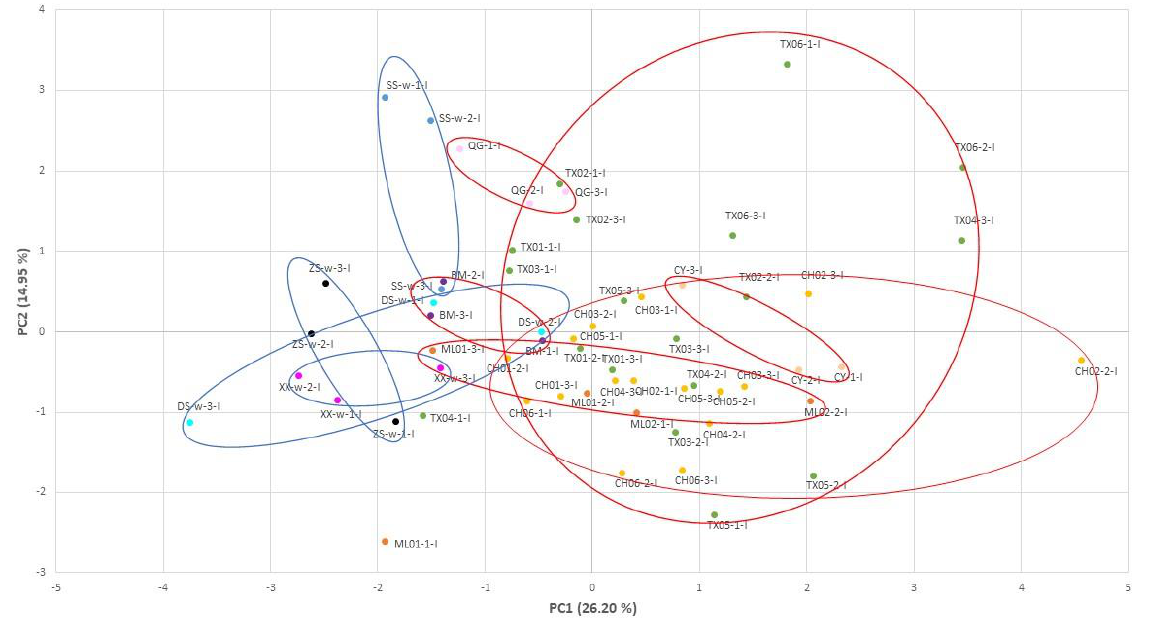
Figure 5. Principal component analysis (PCA) in the inner site of the shells: PCA plotted against the PC1 vs. PC2 axes. Different color of points in the figure means different locations.